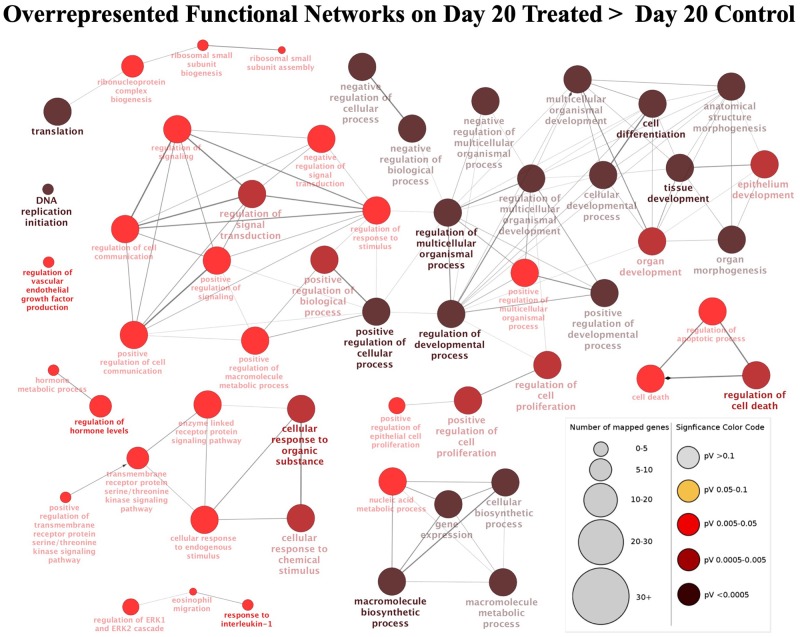
Functional networks found in upregulated differentially expressed genes (DEGs) from the contrast “day 20 treated over day 20 control.” Overrepresented functional terms of “day 20 treated” are shown. Redundant or non-informative terms were removed and the networks obtained were manually rearranged. Number of mapped genes is indicated by the node size while significance of functional terms is denoted by node color (represented in legend at the right bottom corner). Networks more highly represented in CL samples from animals treated until day 20 after ovulation were related to gene expression and translation, signaling, hormone regulation, cell differentiation and death, and immune function.